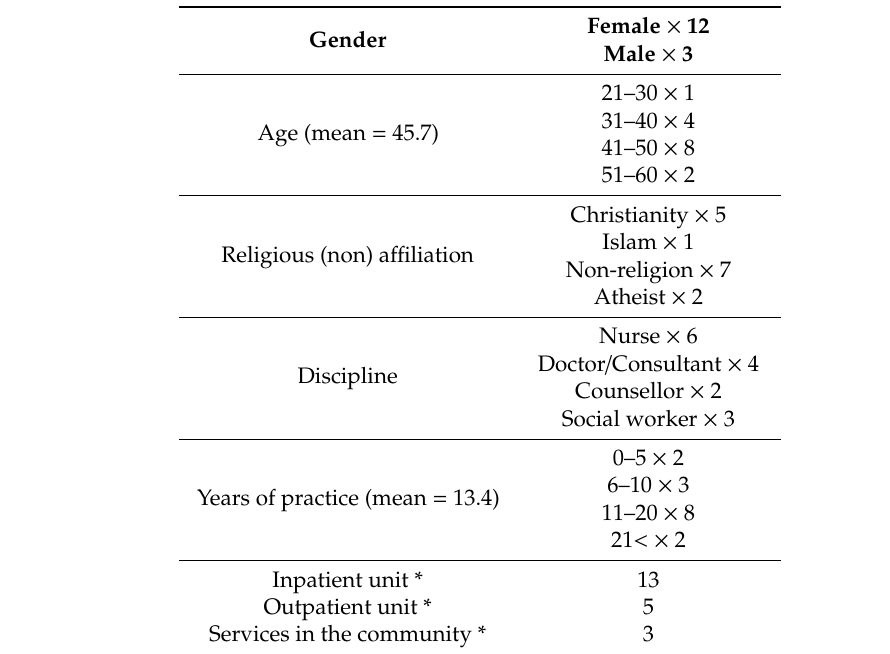
Table 2. Main characteristics of